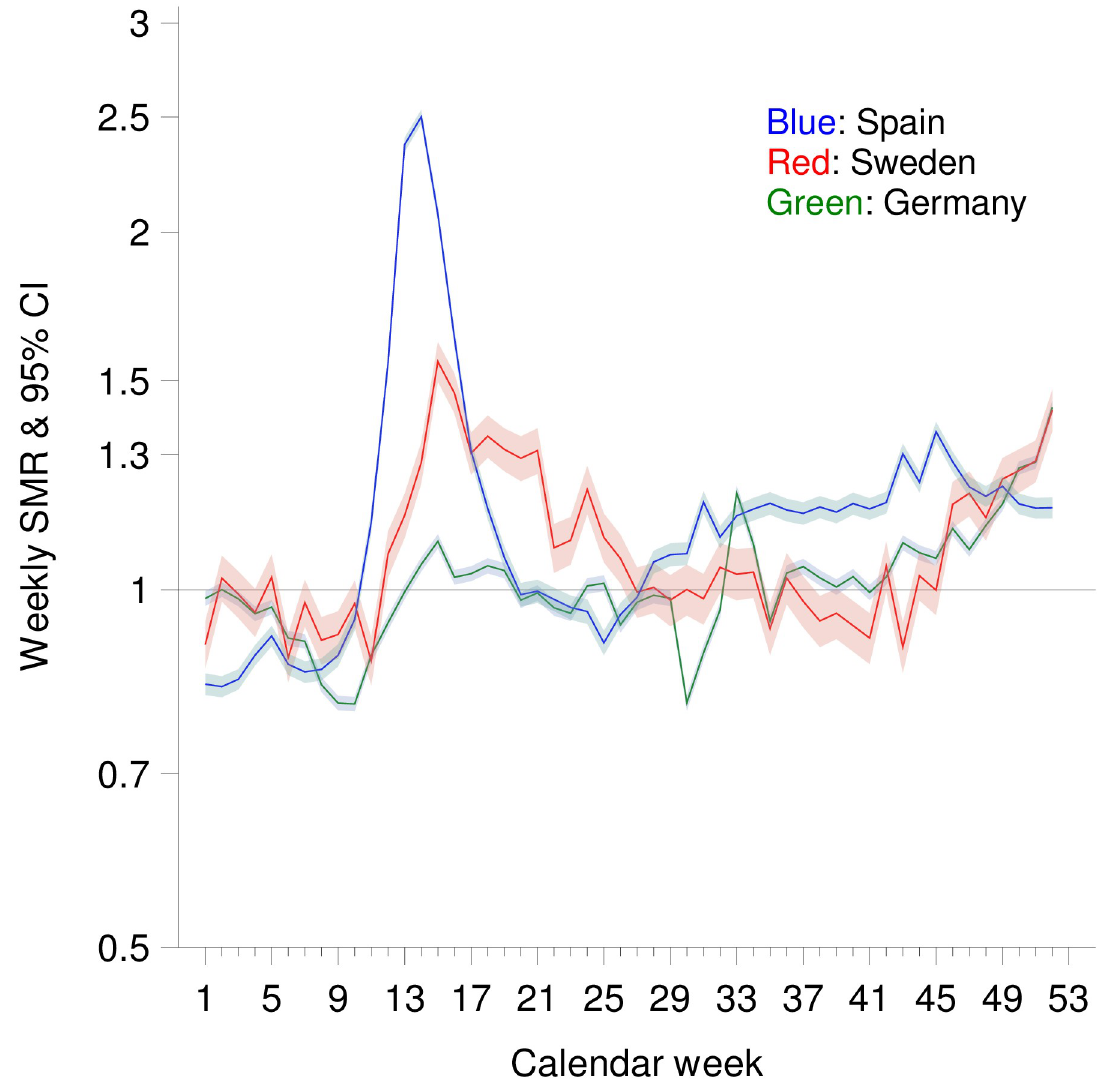
Fig 3. Weekly standardized mortality ratio (SMR) by calendar week in Spain, Germany and Sweden (with consideration of life